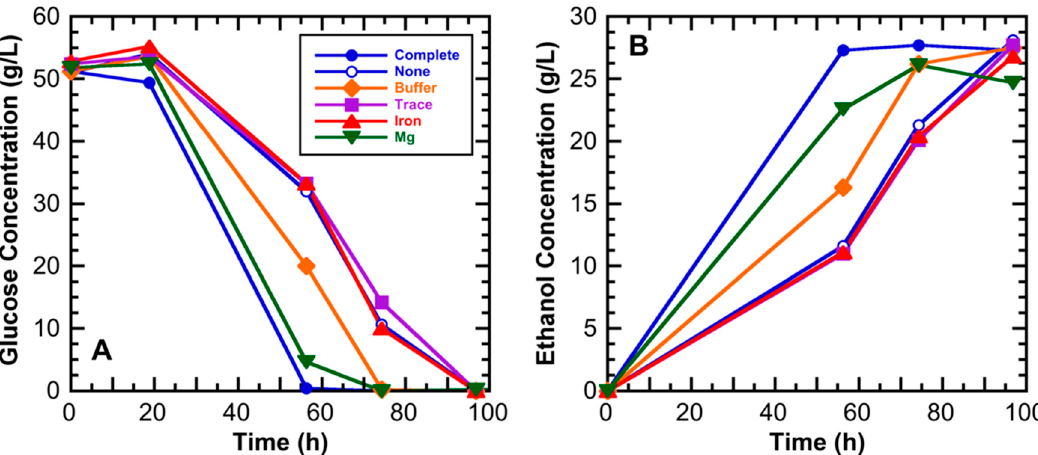
Figure 1. Effect of medium components on the glucose consumption rates and ethanol productivities for S. pastorianus on sugarcane bagasse hydrolysate. ( A ) Glucose; ( B ) ethanol. S. pastorianus was cultured on sugarcane bagasse hydrolysate that initially contained 65 g/L glucose. Cultures in standard medium (Complete, ), none of the medium components (None, ), phosphate buffer only (Buffer, ), trace metal solution only (Trace, ), iron citrate solution only (Iron, ), and magnesium sulfate solution only (Mg, ). The legend for both panels is shown in (A). Only single cultures were conducted for each condition as this was a screening study.